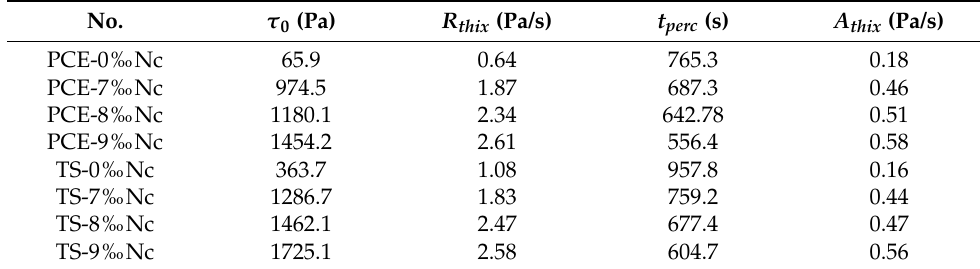
Figure 9. Schematic diagram for the calculation of t perc . Table 4. Fitted parameters for each cement